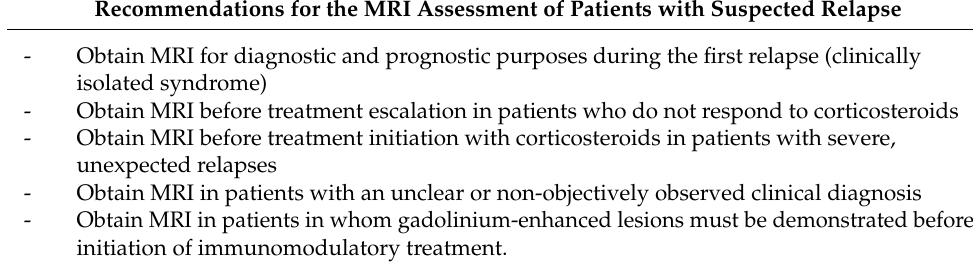
Table 2. Recommendations for the MRI Assessment of Patients with Suspected